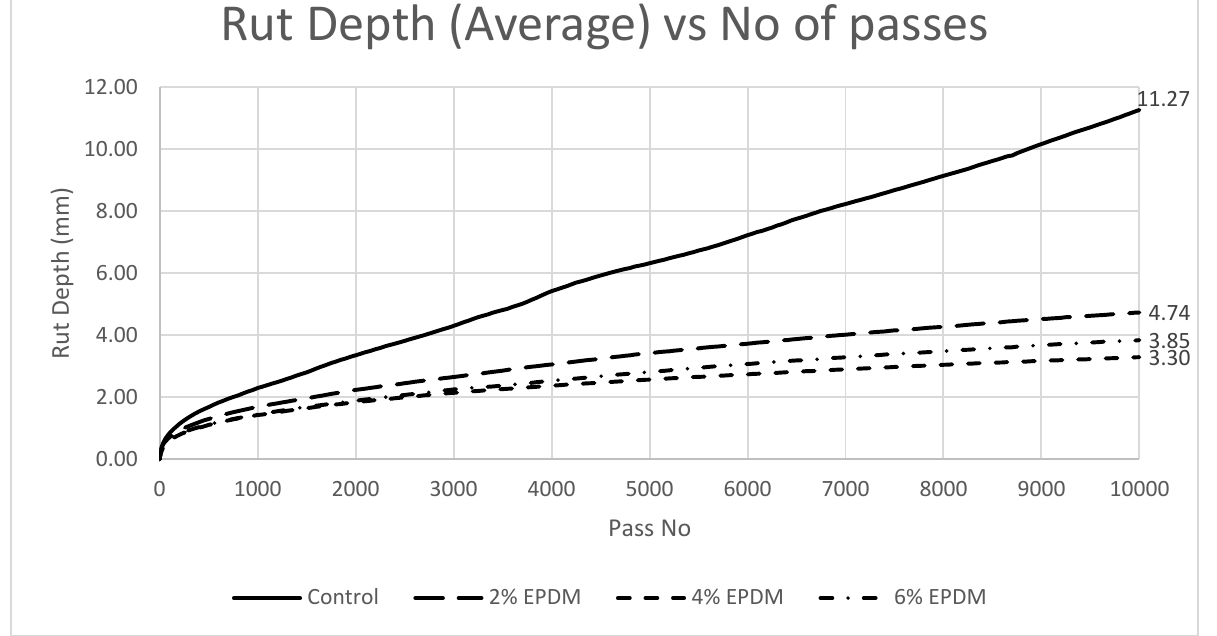
Figure 6. Wheel-tracking test results.